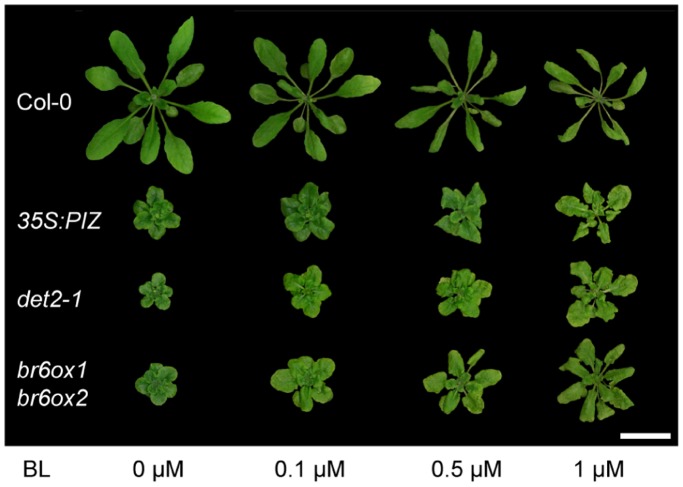
Exogenous BL partly complements the dwarf phenotype of 35S:PIZ seedlings.Plants grown on soil were sprayed every 4 days with an aqueous solution of BL at 0, 0.1, 0.5 and 1 µM for 4 weeks. Similar to BL biosynthesis mutants det2-1 and br6ox1 br6ox2, the dwarf phenotype of 35S:PIZ seedlings is partially rescued by exogenously applied BL.